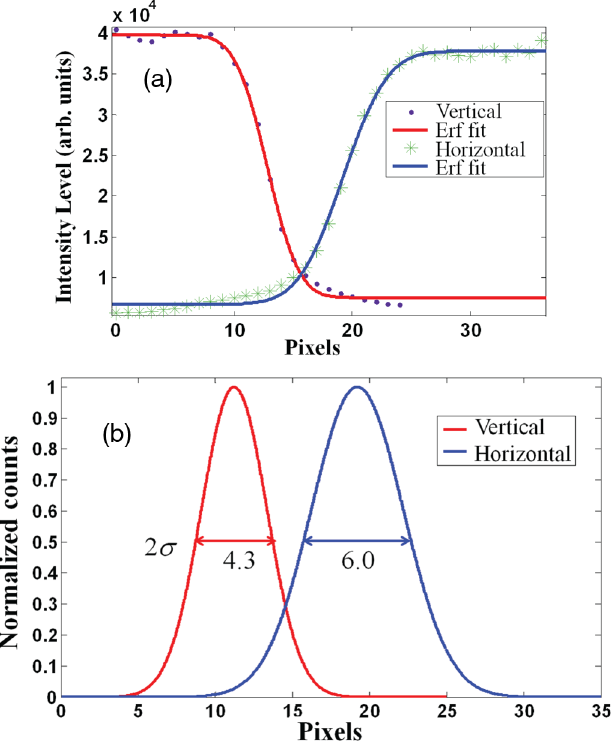
FIG. 6. (top) Horizontal and vertical scan of resolution target corner shown above in Fig. 5; and (bottom) related Gaussian